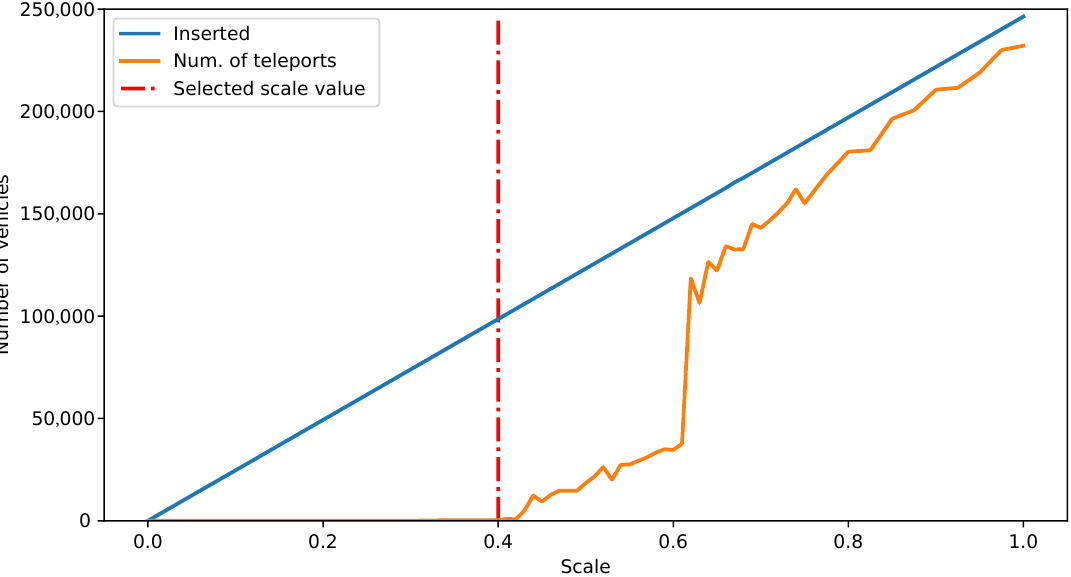
Figure 4. Evolution of the teleports number according to the scale